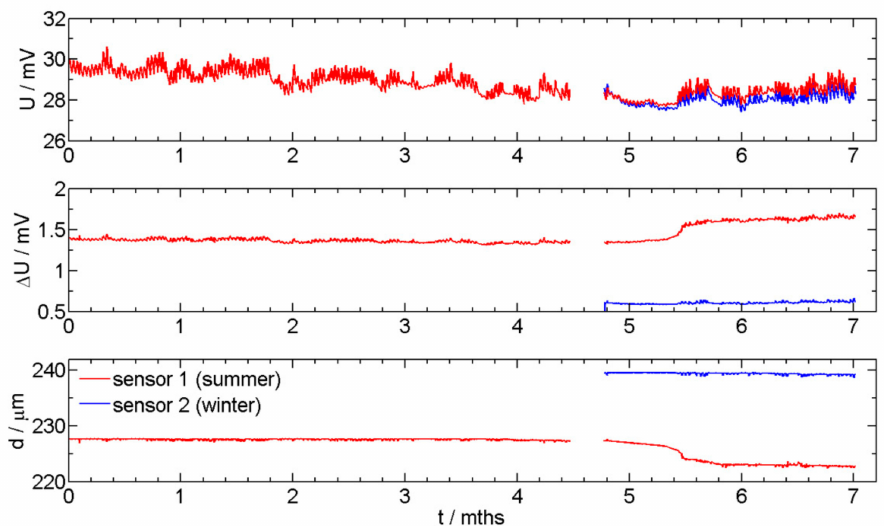
Figure 4. The corrosion sensor readout (the output potential ( U ), the potential drop on the Wheatstone bridge ( ∆ U ), the remaining thickness of the sensor (d) exposed for 6 months (red curve), and of the sensor exposed for 2 months (blue curve).